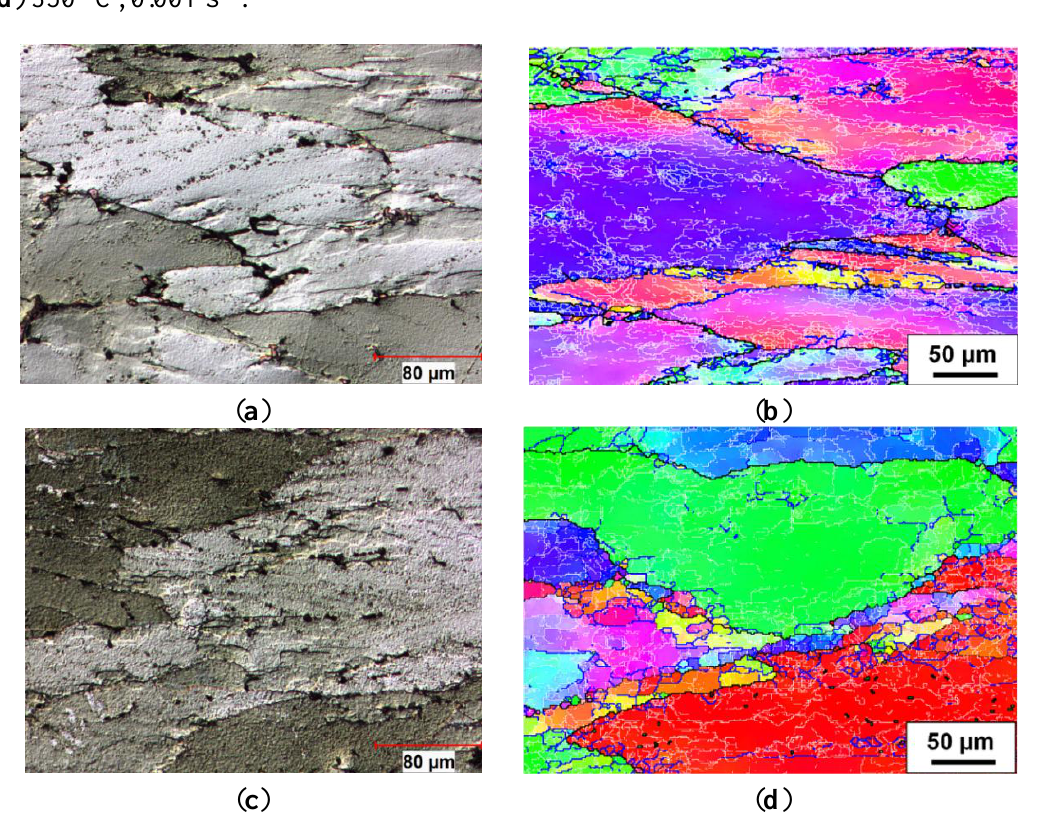
Figure 6. Optical micrographs and orientation imaging maps showing deformed microstructures under different deformation conditions: ( a , b ) 350 °C, 0.1 s −1 ; and ( c , d ) 350 °C, 0.001 s −1